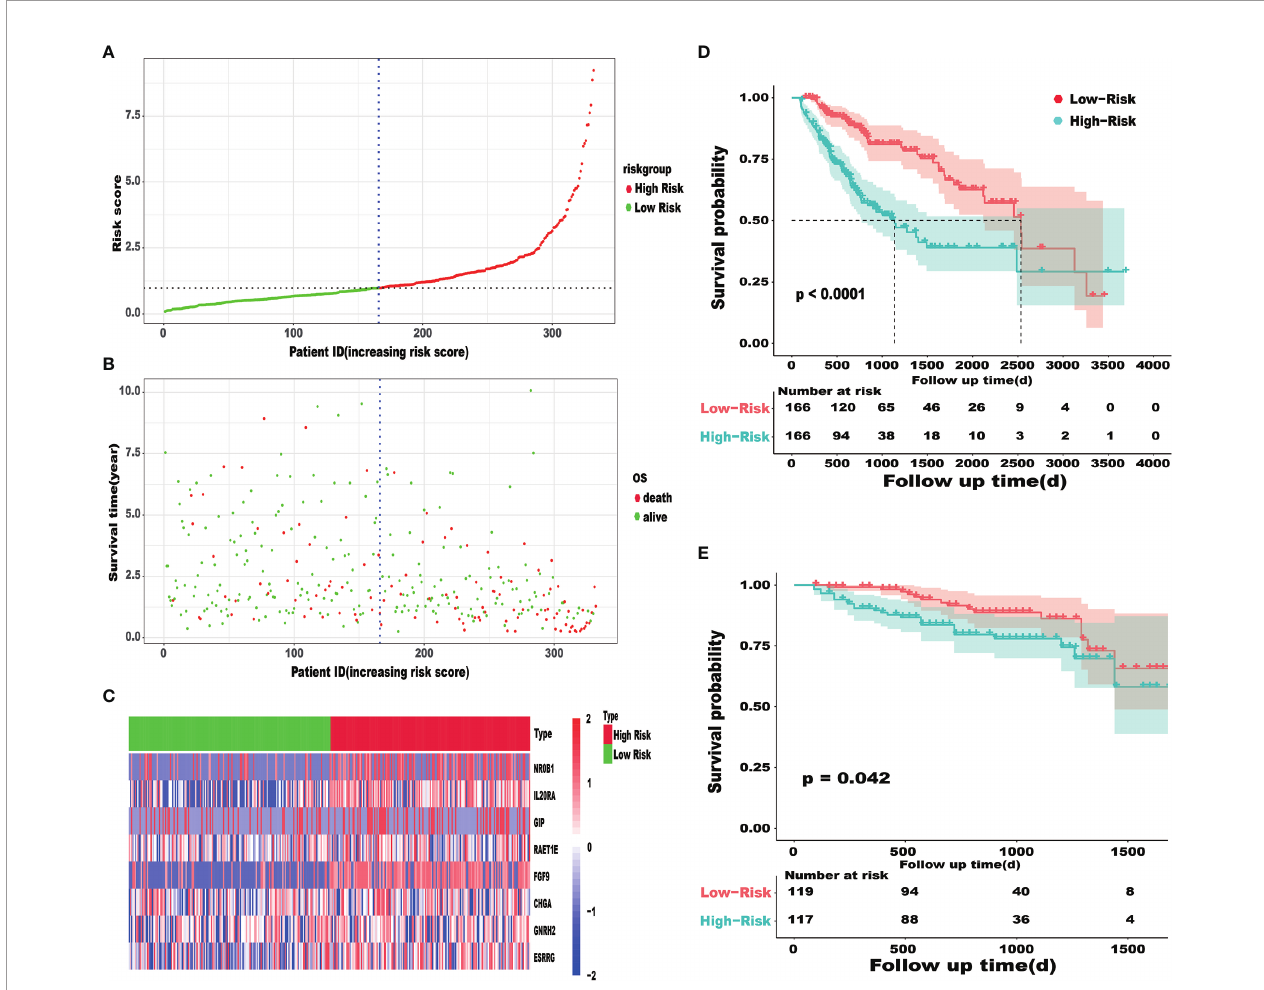
FIGURE 3 | IRRSM was created by SIRGs (A – C) . The distribution of high-risk group and low-risk group (A) . Survival status of the high-risk and the low-risk group (B) . The heatmap of the expression levels of twelve SIRGs (C) ; Survival curve for the high risk and low risk groups of HCC patients in the TCGA database (D) . Survival curve for the high risk and low risk groups of HCC patients for validation in ICGC database (E) .